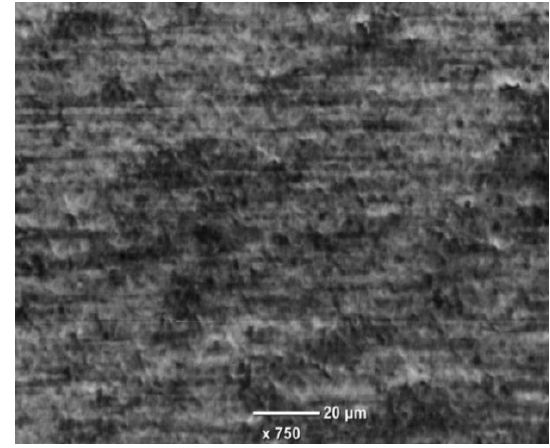
Figure 6. SEM image of the membrane filter; the scale bar is 20 µm.